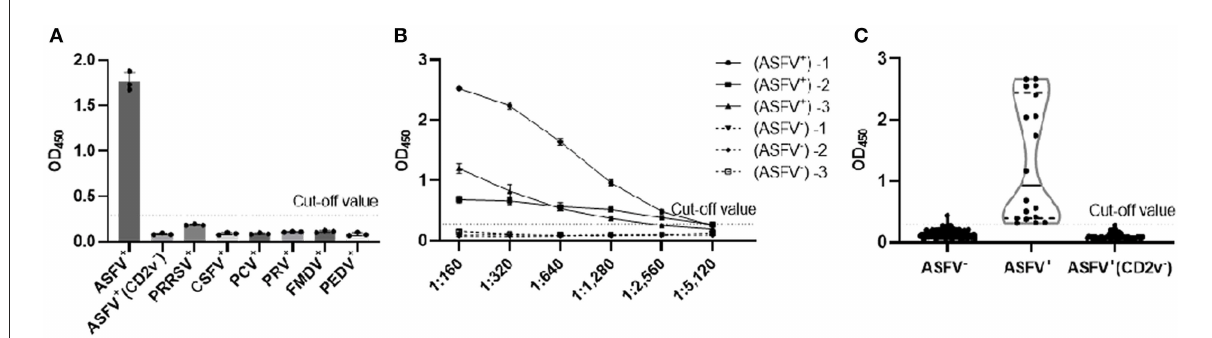
FIGURE4 Determination of the specificity, sensitivity, and compliance rate of the CD2v-iELISA. The CD2v-iELISA did not detect ASFV + (CD2V − ), PRRSV + , CSFV + , PCV + , PRV + , FMDV + and PEDV + serum samples at 1:160 dilution (A) . Three clinical ASFV + and three ASFV − serum samples were diluted from 1:160 to 1:5,120 to determine the highest dilution of serum detected in the assay according to the cut-off value (B) . The CD2v-iELISA was used to detect ASFV + ( n = 18), ASFV − ( n = 112), ASFV + (CD2v − ) ( n = 49) serum samples to determine the assay compliance rate of the assay according to the cut-off value (C) .